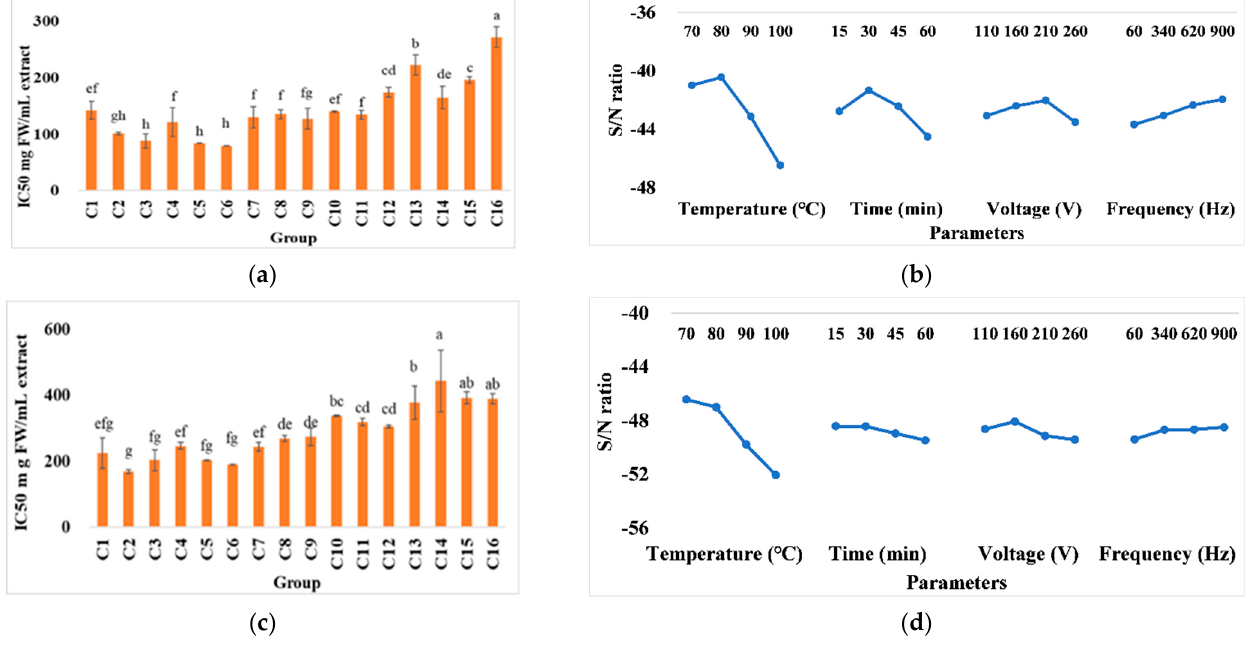
Figure 6. ( a ) DPPH assay with ( b ) the response graph of lower-better and ( c ) the ABTS assay with ( d ) the response graph of the lower-better signal-to-noise ratios of various conditions in ohmic heating. Values C1 − C16 represent pineapple cores in different treatment conditions including temperature ( ◦ C), time (min), voltage (V), and frequency (Hz), respectively: 1: 70, 15, 110, and 60; 2: 70, 30, 160, and 340; 3: 70, 45, 210, and 620; 4: 70, 60, 260, and 900; 5: 80, 15, 160, and 620; 6: 80, 30, 110, and 900; 7: 80, 45, 260, and 60; 8: 80, 60, 210, and 340; 9: 90, 15, 210, and 900; 10: 90, 30, 260, and 620; 11: 90, 45, 110, and 340; 12: 90, 60, 160, and 60; 13: 100, 15, 260, and 340; 14: 100, 30, 210, and 60; 15: 100, 45, 160, and 900; and 16: 100, 60, 110, and 620. The same letters show insignificant differences in the same rows ( p < 0.05). The results are reported as means ± SD.